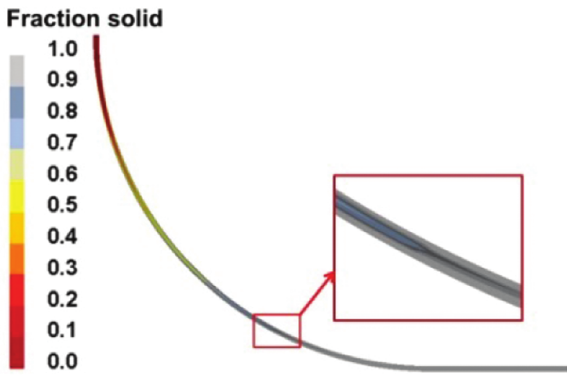
Figure 2: Solidification distribution of continuous casting process.